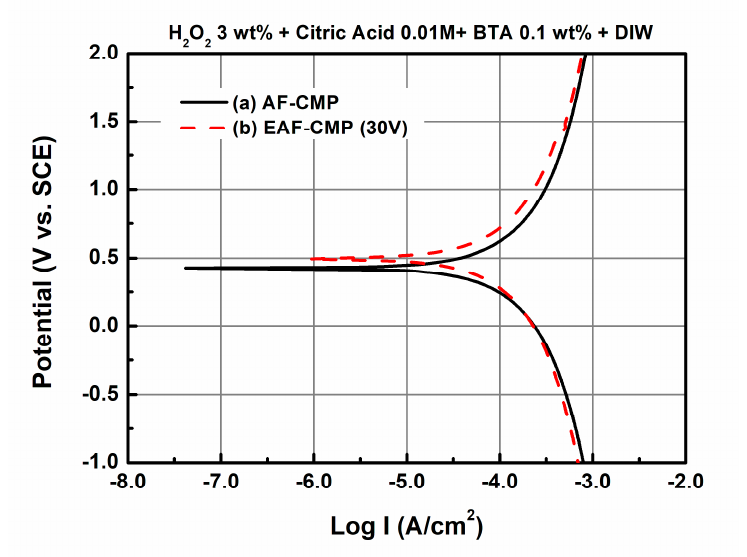
Figure 3. Potentiodynamic polarization curves of abrasive-free CMP solution; ( a ) no AC voltage and ( b ) AC 30 V.